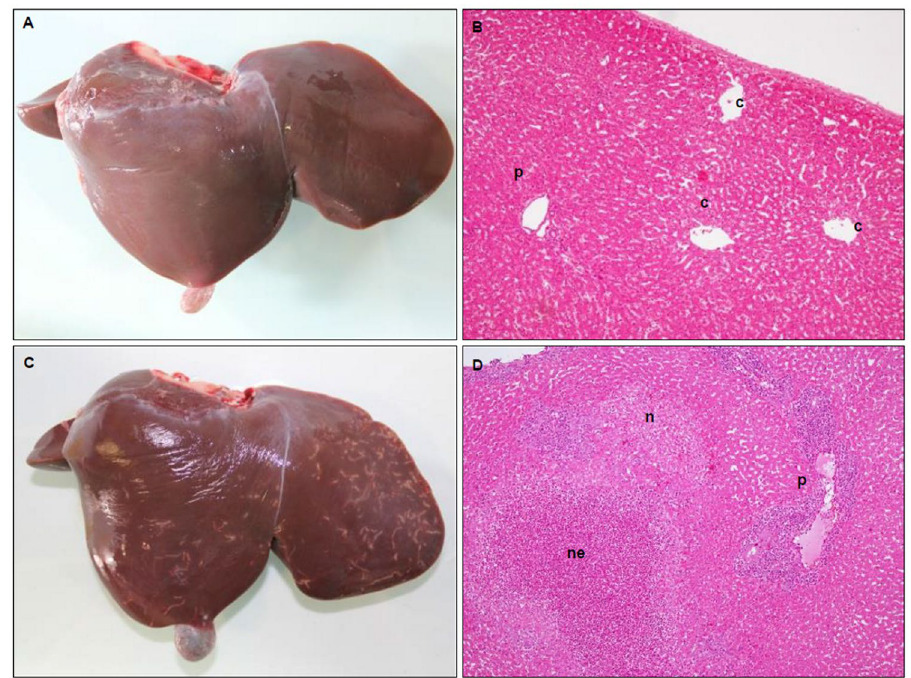
Figure 1. Comparison of gross and microscopical liver pathology between uninfected ( A and B ) and infected ( C and D ) animals. ( A ) Liver showing no apparent gross pathology. ( B ) HE stained liver microphotograph showing centrilubular veins (c) and portal spaces (p) with blood vessels and bile ducts and absence of inflammatory infiltrate (Magnification x400). ( C ) Liver showing white tortuous tracts caused by F. hepatica . ( D ) HE stained liver microphotograph displaying acute small necrotic foci without inflammatory infiltrate (n), acute necrotic foci with presence of abundant necrotic inflammatory cells (ne) and severe inflammatory infiltrate in adjacent portal spaces (Magnification